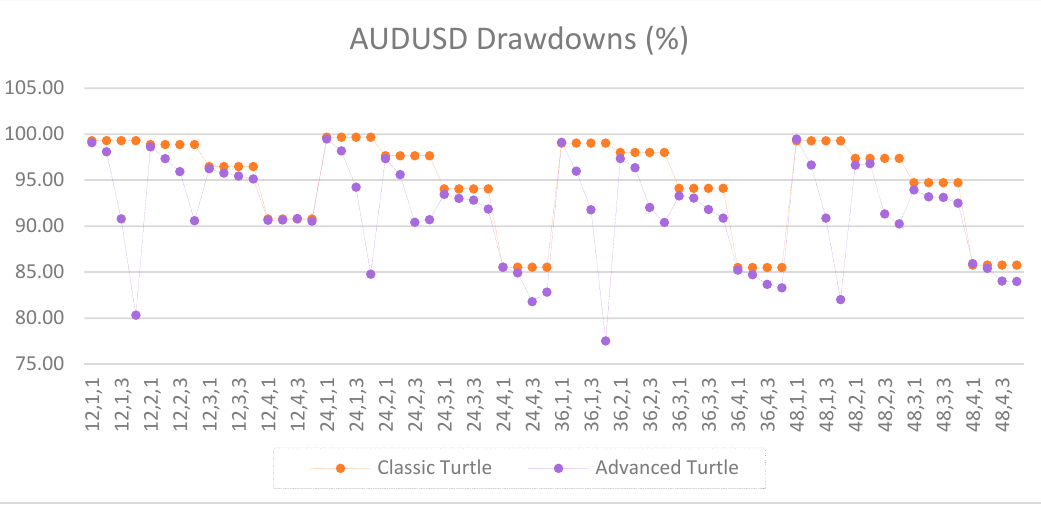
Figure A2. Drawdowns of AUDUSD as percentage of equity between the classic and the advanced Turtle systems for every combination of N, X, Y for the fast parameters (20, 40).